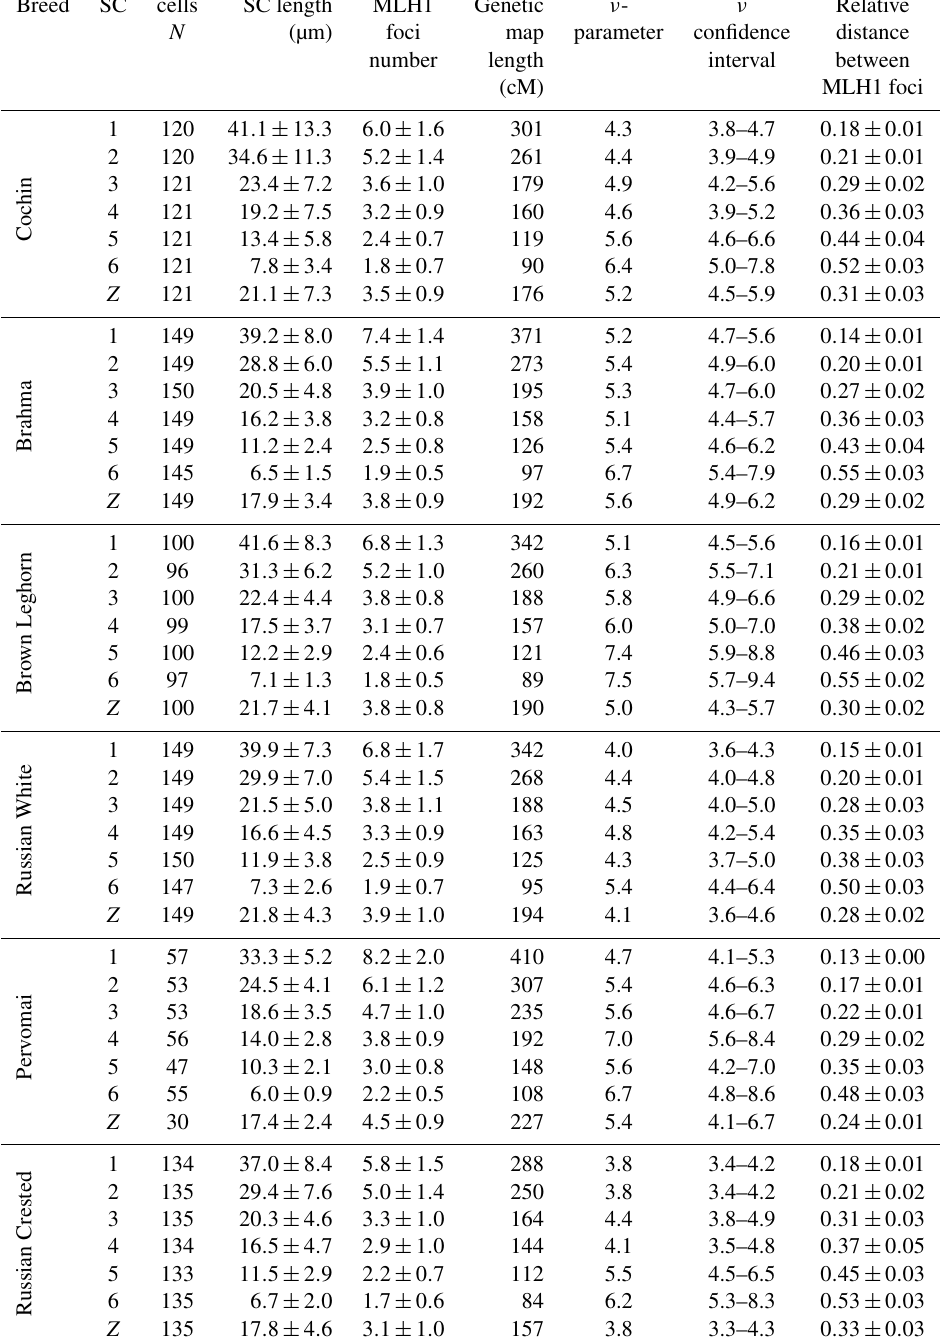
Table 2. Recombination characteristics of macrochromosomes in roosters of different breeds.